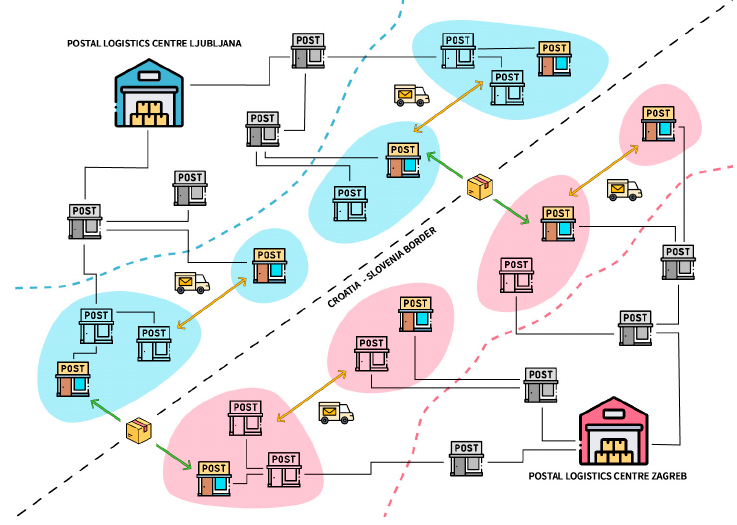
Figure 2. A Cognitive Advisor (CA)-assisted parcel workflow on a cross-border region.